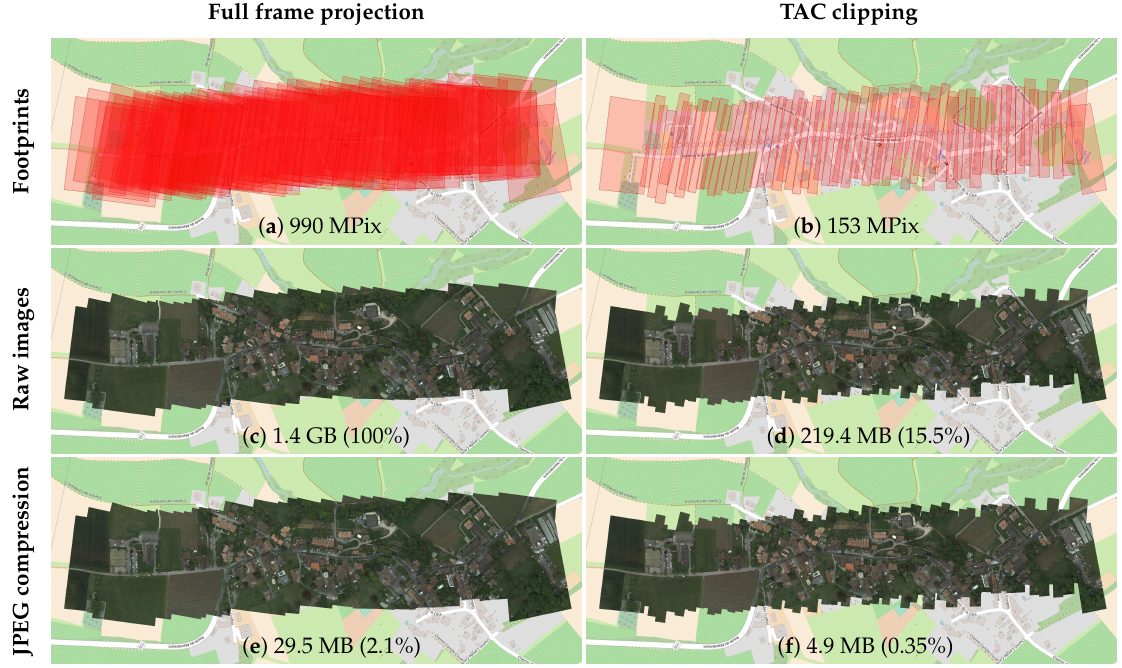
Figure 7. Case study: Image data size of a sample scene comparing raw imagery, application of JPEG compression, application of TAC clipping and combined application of JPEG compression and TAC clipping. Sample scene comprising 63 aerial images captured by the demonstration UAV camera